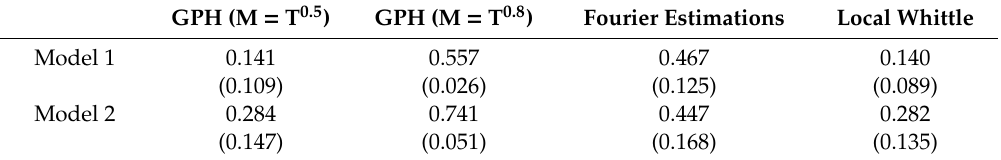
Table 1. Monte Carlo Simulation results. The table reports the test results of the Monte Carlo